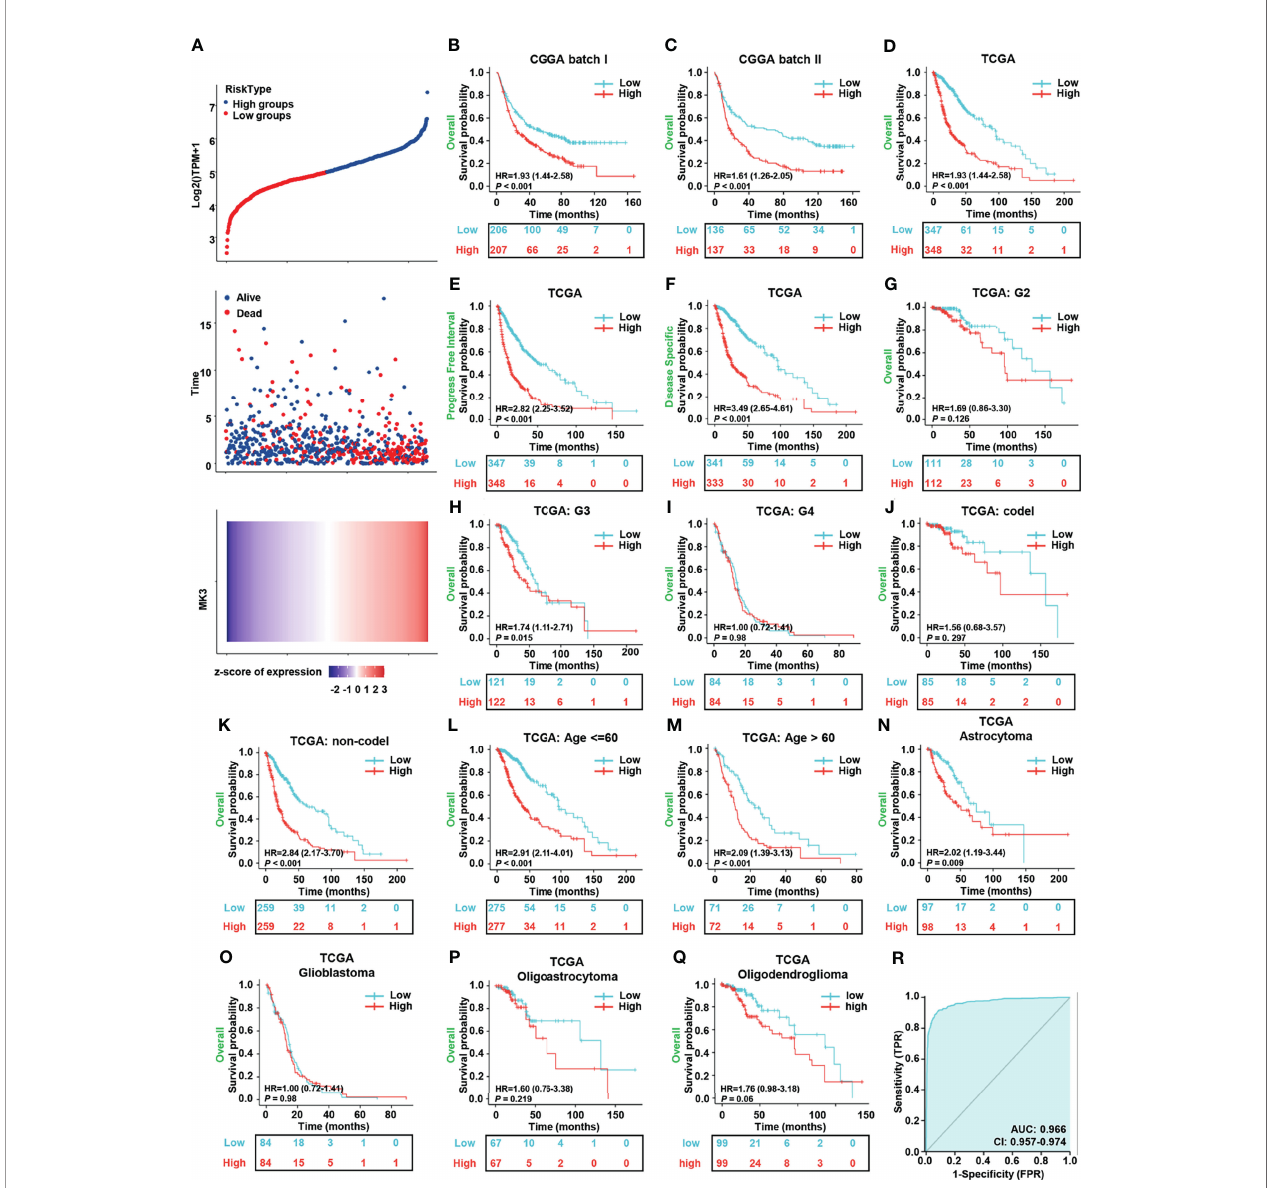
FIGURE 3 | Overexpression of MK3 was closely related to the poor prognosis of glioma patients. (A) The relationship between survival time, survival status of glioma patients, and MK3 expression in TCGA dataset. Top: the curve of risk score. The dotted line represents the median risk score and divided the patients into low-risk and high-risk groups. Median: scatter plot distribution of survival time and survival status corresponding to the MK3 expression of different samples. Bottom: heatmap of MK3 expression. (B, C) The KM survival analysis for the correlation of MK3 with overall survival of glioma patients in CGGA batch I (B) and batch II (C) datasets. (D – F) The KM survival analysis for the correlation of MK3 expression with OS (D) , PFI (E) , and DSS (F) of glioma patients in TCGA dataset. (G – Q) Different subgroup analyses of KM for overall survival including WHO grade G2 (G) , G3 (H) , G4 (I) , and 1p/19q codeletion status: codel (J) , non-codel (K) , age less than or equal to 60 years (L) , age greater than 60 years (M) , and histological type astrocytoma (N) , glioblastoma (O) , oligoastrocytoma (P) , and oligodendroglioma (Q) of glioma patients in TCGA dataset. (R) ROC curve of GBM, LGG tissues ( n = 1,157), and normal brain tissues ( n = 689) from TCGA and GTEx databases for validating the diagnostic value of MK3 in glioma patients. TCGA, The Cancer Genome Atlas; KM, Kaplan – Meier; CGGA, Chinese Glioma Genome Atlas; OS, overall survival; PFI, progression-free interval; DSS, disease-speci fi c survival; ROC, receiver operating characteristic; GBM, glioblastoma; LGG, low-grade glioma; GTEx, Genotype-Tissue